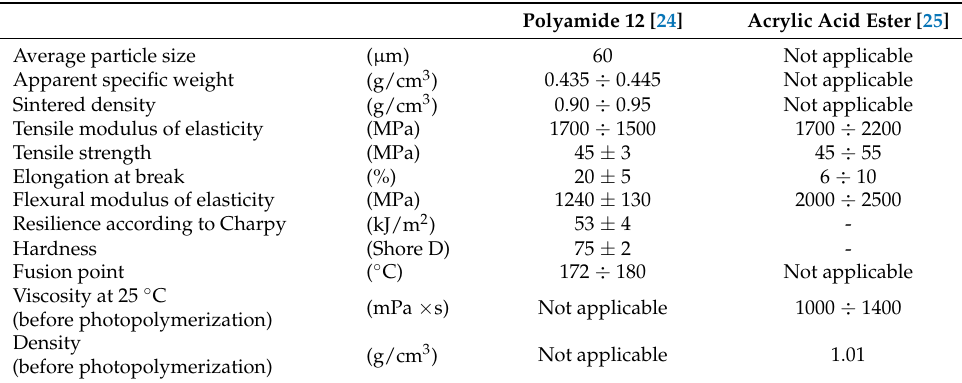
Table 1. Nominal characteristics of the used materials.